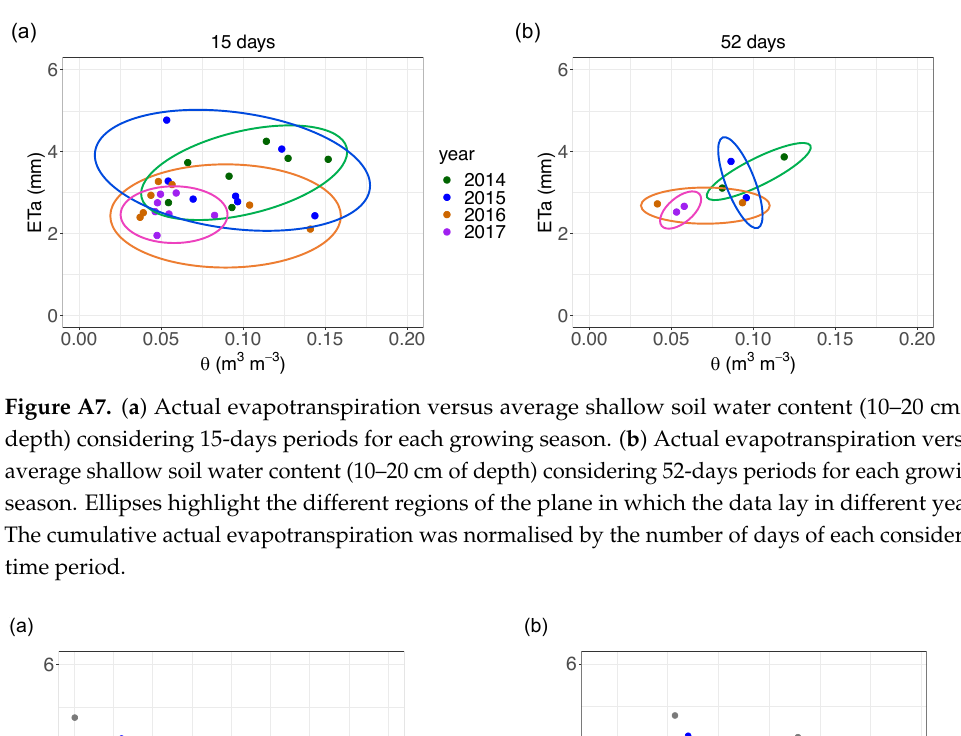
Figure A6. Frequency density distributions (in every growing season) of three micrometeorological variables. ( a ) Wind speed ( U ). ( b ) Vapour pressure deficit. ( c ) Air temperature. Dashed lines represent the mean values for each variable in each growing season. Based on 2015 data as an example, light red histograms represent the density distribution between 05:00 and 7:00 and between 17:00 and 20:00. The grey histograms refer to the hours between 08:00 and 16:00.